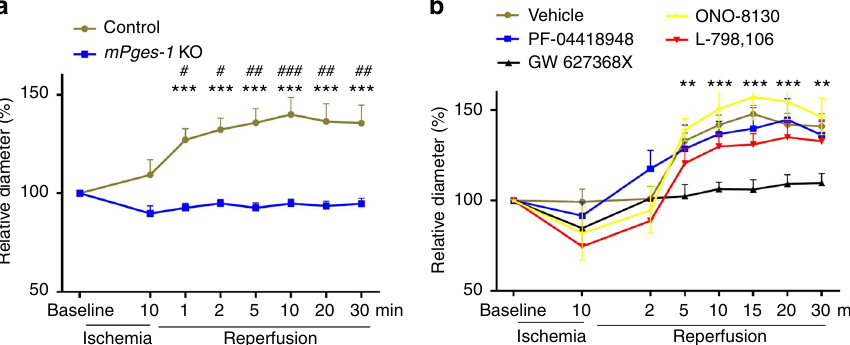
Fig. 4 mPges-1 deletion and PGE receptor antagonism in arteriolar dilation in I/R. Arterioles of 15 – 25 μ m in diameter were randomly selected in the extremity of hindlimb. Vascular response (percentage change of diameter over baseline) to I/R was assessed for mice de fi cient in mPges-1 ( a ). The vessel diameter was not different between control ( n = 9) and mPges-1-1 KO ( n = 7) mice at baseline (21.34 ± 0.72 vs 20.38 ± 1.40 μ m, p = 0.54, unpaired Student ’ s t test). b The vascular response was also assessed for WT mice i.v. treated with vehicle ( n = 6), or an antagonist EP1 (ONO-8130, Ki = 1.9 nM, n = 5), EP2 (PF-04418948, IC50 = 16 nM, n = 5), EP3 (L-798106, Ki = 0.3 nM, n = 7) or EP4 (GW627368X, Ki = 100 nM, n = 7), with each drug at 5 mg/kg. There was no difference in baseline vessel diameter between groups. Two-way ANOVA with Bonferroni ’ s test was used. * demarks statistical comparison between control and mPges-1 KO, or between GW 627368X and vehicle. # shows comparison to baseline. Error bar indicates